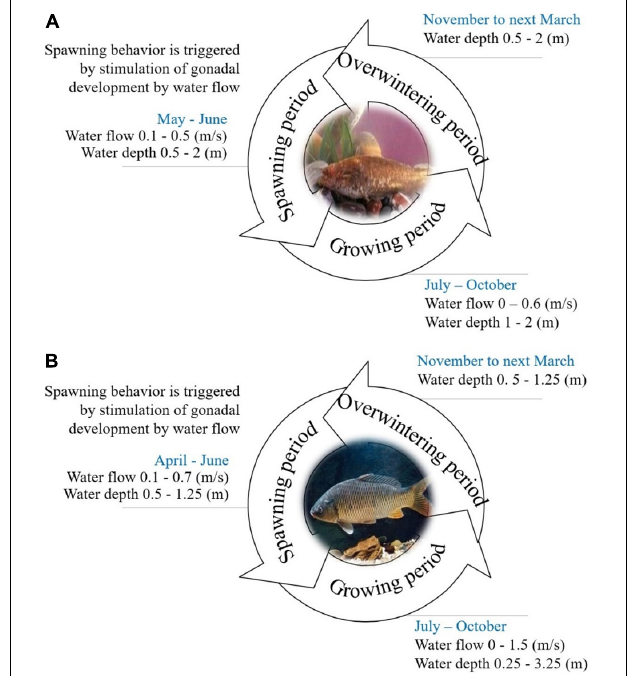
FIGURE 5 | Environmental factors of fish habitat in the Yellow River (Wu et al., 2006; Huang et al., 2016; Wang, 2017). (A) The environmental factors of Silurus lanzhouensis habitat in the Yellow River. (B) The environmental factors of Cyprinus carpio habitat in the Yellow